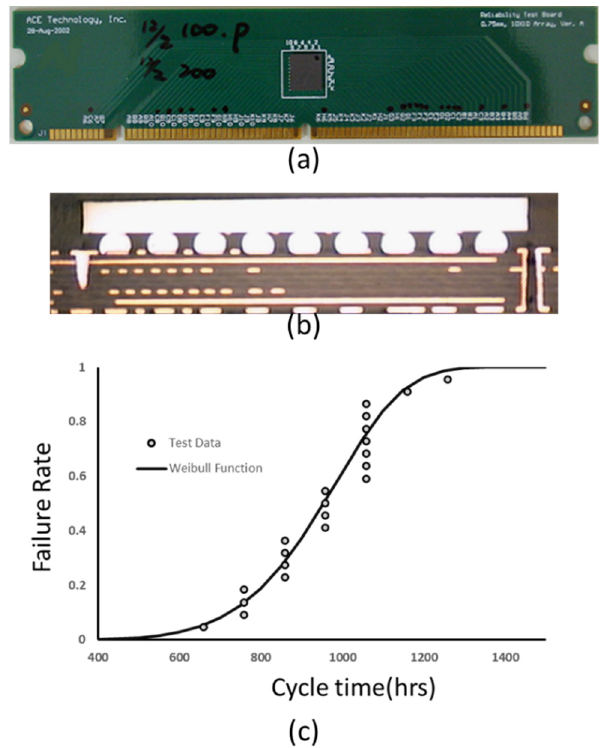
Figure 5. Thermal cycling results: ( a ) the test board, ( b ) the Weibull plot, ( c ) Weibull solder fatigue failure experimental result of 21 samples.